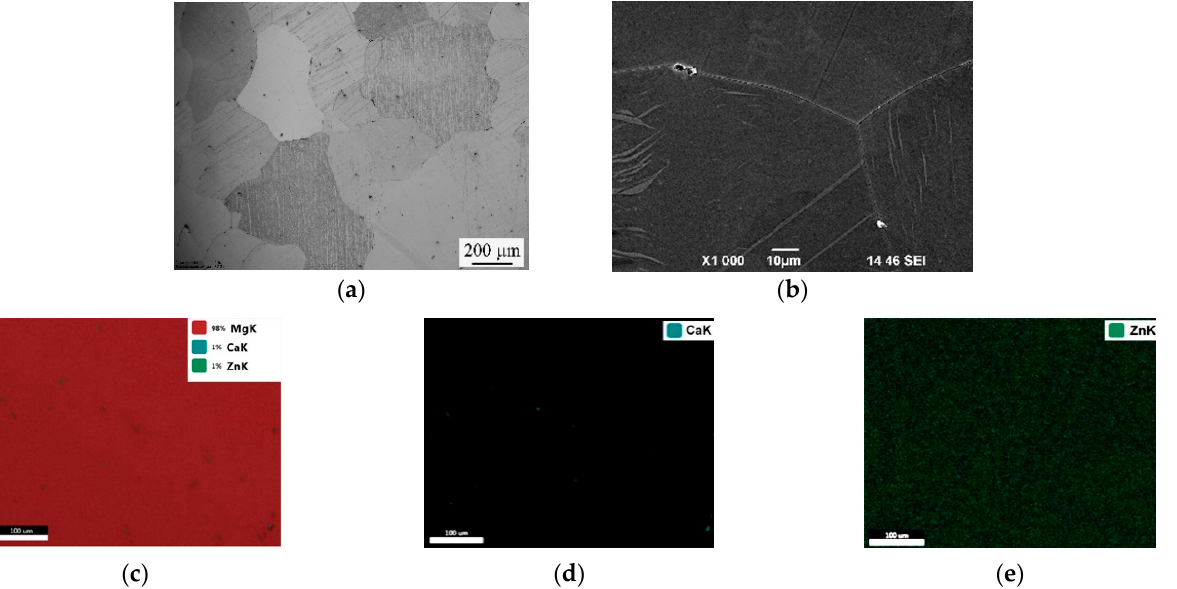
Figure 7. Structure of the Mg ‐ 1%Zn ‐ 0.2%Ca alloy in the homogenized state: ( a ) optical microscopy; ( b ) scanning electron microscopy (SEM); energy ‐ dispersive spectroscopy (EDS) elemental mapping demonstrating the solute distribution: Mg, Ca, Zn ( c ), Ca ( d ), Zn ( e ). During the HPT processing, a refined grain–subgrain structure with a mean grain size of 90 nm formed in the Mg ‐ 1Zn ‐ 0.2Ca alloy samples (Figure 8a). Most grains are characterized by a high defect density and large internal stresses. Also found in the structure of the HPT ‐ processed samples are the fine ‐ dispersed Ca 2 Mg 6 Zn 3 particles with a size of 10 nm, visible as white dots in the dark ‐ field image (Figure 8b). The volume fraction of the fine ‐ dispersed particles is about 1%.